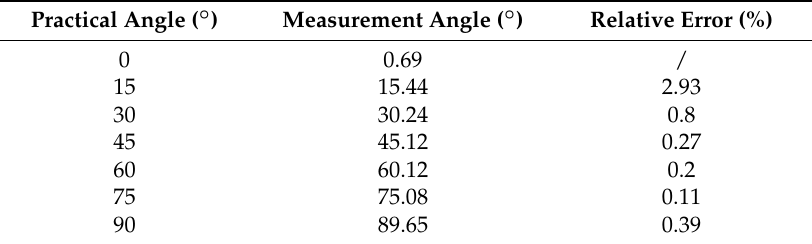
Table 1. Measurement accuracy of detection using MPU6050 angle